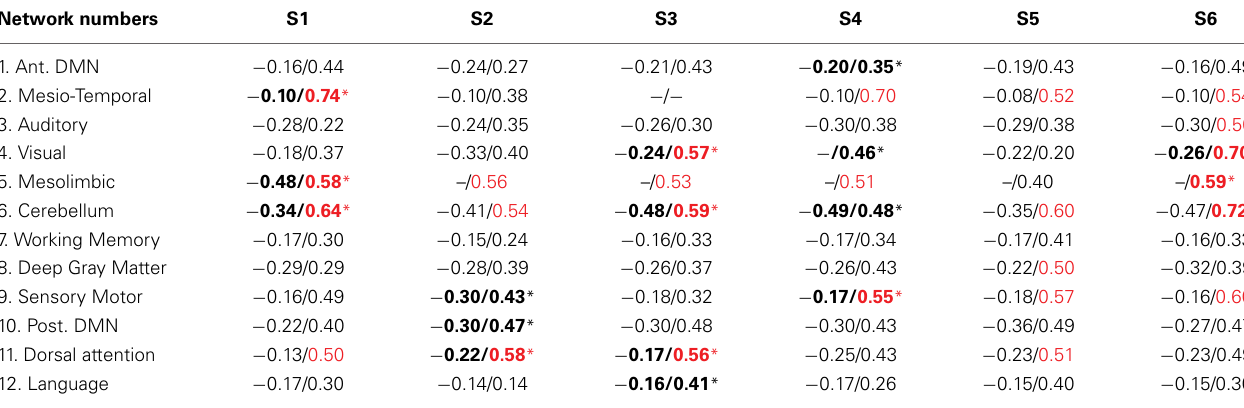
Table 2 | Analysis of the most salient findings detected by